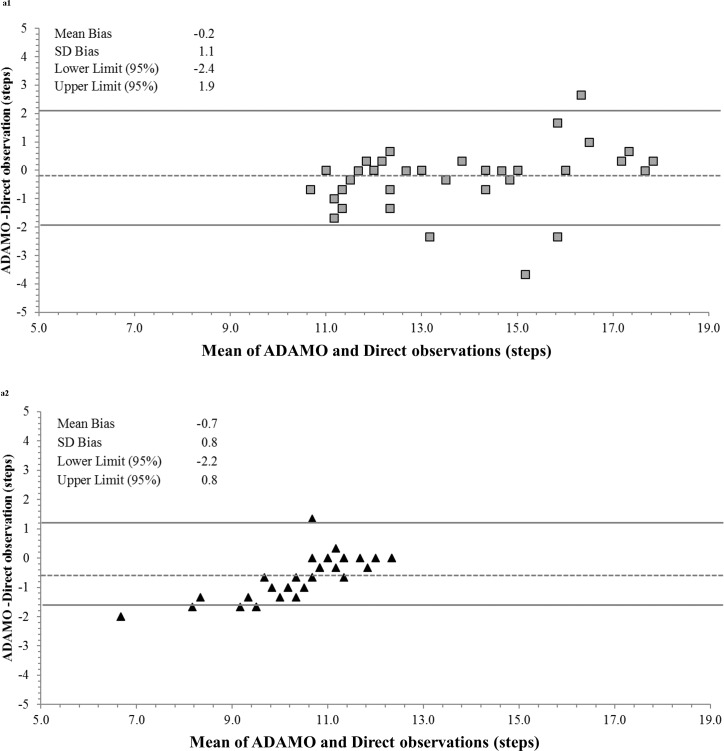
Bland–Altman plots between criterion and ADAMO Care Watch during TUG test.Dashed lines represent mean bias differences; Solid lines represent 95% prediction intervals; a1 represent Older adults and a2 represent Young adults.